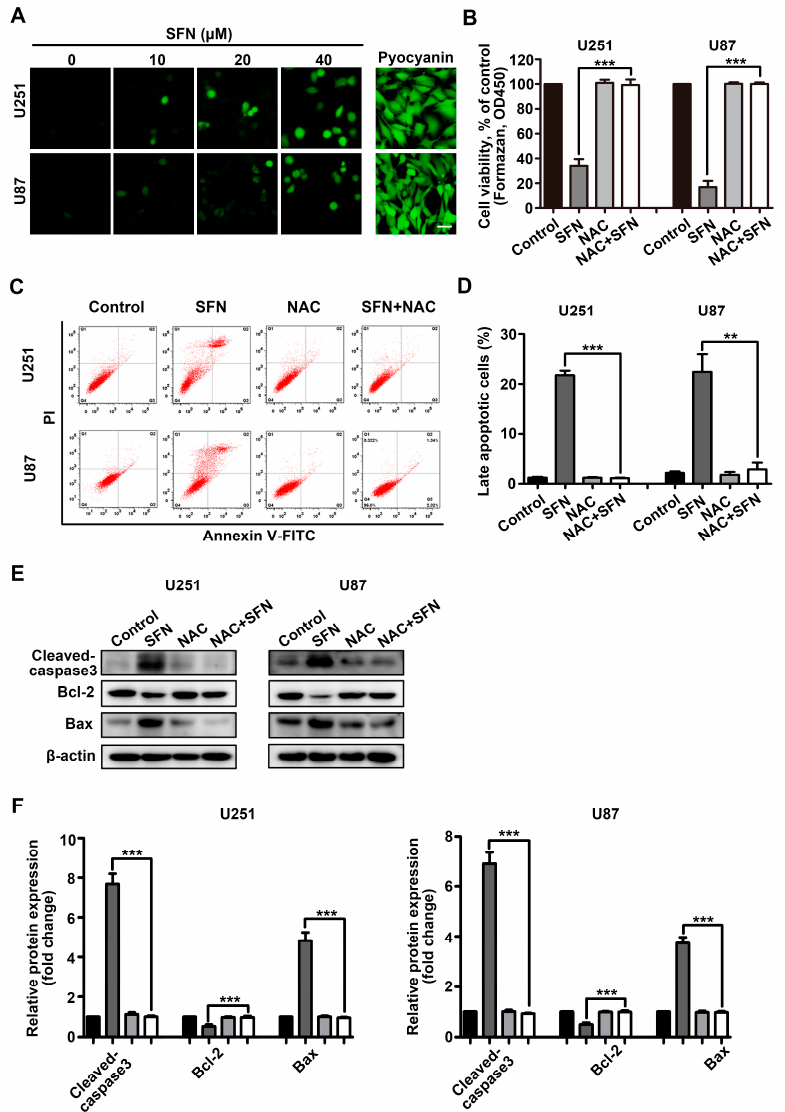
Figure 3. Intracellular ROS is involved in cellular apoptosis induced by SFN. ( A ) Cells were exposed to the indicated concentrations of SFN for 24 h. The level of intracellular ROS was assessed using DCFH-DA staining and observed by fluorescence microscope. As a positive control, cells were treated with pyocyanin (200 µM). Bar: 20 µm; ( B ) cells were pre-incubated with or without NAC (3 mM) for 1 h followed by the addition of SFN (40 µM) for a further 24 h. Cell viability was measured by CCK-8 assay; ( C ) cells were treated with SFN (40 µM) in the absence or presence of NAC. The apoptosis was determined by Annexin V/PI staining and analyzed by flow cytometry. Cells in Q2 quarters (Annexin V positive/PI negtive) represented early apoptotic cells. The double-positive cells in Q3 quarters represented late apoptotic cells; ( D ) the percentages of late apoptotic cells relative to the total population were quantified; ( E ) cells were treated with SFN (40 µM) for 24 h after pre-incubation with or without NAC (3 mM). The cell lysates were subjected to Western blot using anti-cleaved caspase3, anti-Bcl-2 and anti-Bax, antibodies; and ( F ) the bands corresponding to each protein were quantified and normalized relative to band intensities for control group. Data are represented as means ± SD. ** p < 0.01, and *** p < 0.001 indicates difference between SFN alone versus co-treatment with NAC.